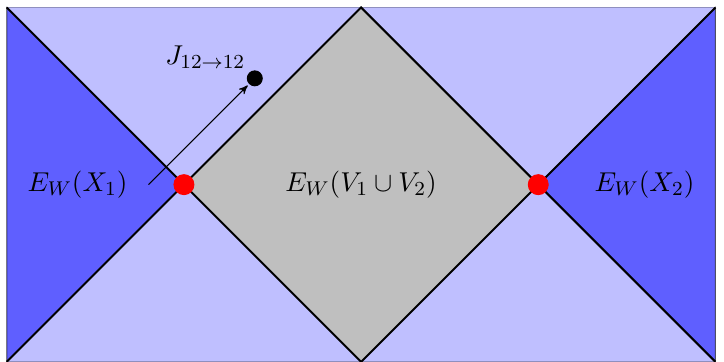
Figure 10. A cross-section of the bulk spacetime when the entanglement wedge of V 1 [ V 2 is connected. The entanglement wedge of the complementary domain of dependence X has two disconnected components E W ( X 1 ) and E W ( X 2 ). If J 12 ! 12 is in the future of one of these wedges E W ( X i ), X i can signal J 12 ! 12 with a local operator in its entanglement wedge; this contradicts the fact that each X i can only signal one of the output points r i